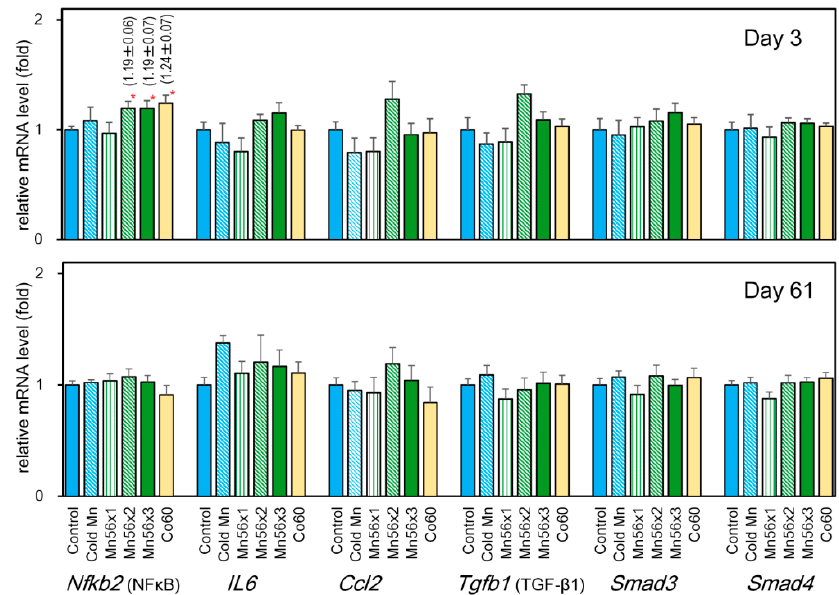
Figure 3. Relative mRNA expression levels of Nfkb1 , Il6 , Ccl2 , Tgfb1 , Smad3 , and Smad4 genes in the liver of rats on day 3 (top) and day 61 (bottom) after the exposure. Control (solid blue): untreated group; Cold Mn (diagonal blue stripes): exposed to stable MnO 2 particles; Mn56x1 (green stripes), Mn56x2 (diagonal green stripes), and Mn56x3 (solid green): exposed to 56 MnO 2 particles at the activity of 2.6 × 10 8 , 5.5 × 10 8 , and 8 × 10 8 Bq, respectively; Co60 (solid yellow): exposed to 60 Co γ -rays (2 Gy) * p < 0.05 vs. control.